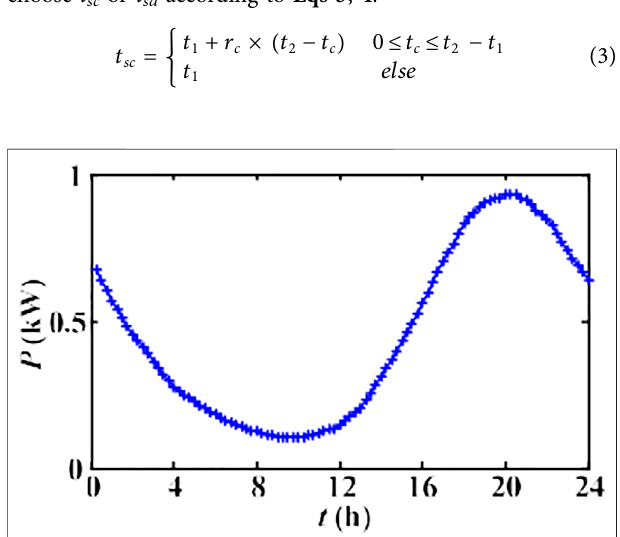
FIGURE 6 | Original charging requirements for a single